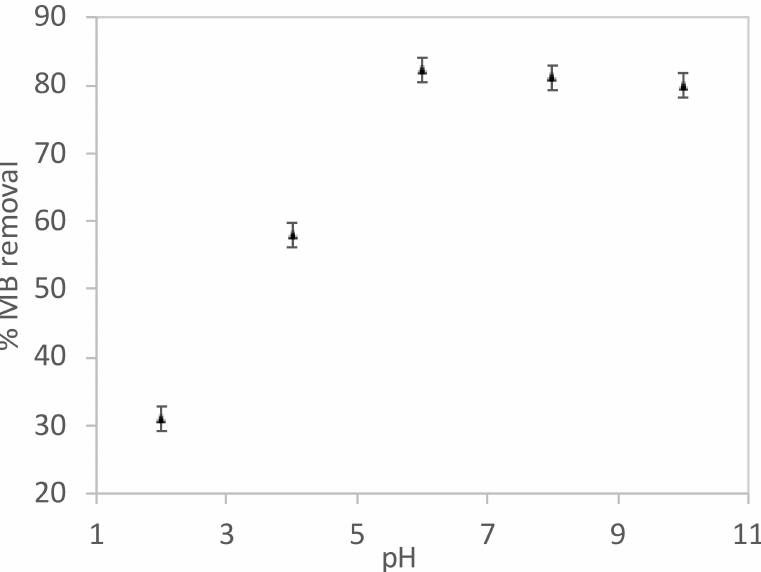
Figure 6. The pH effect study for the %MB removal (0.001 g biomass and 100 mL of solution with 50 ppm of MB). The described system was stirred at 150 rpm under controlled temperature conditions (289 K) for 3 h).